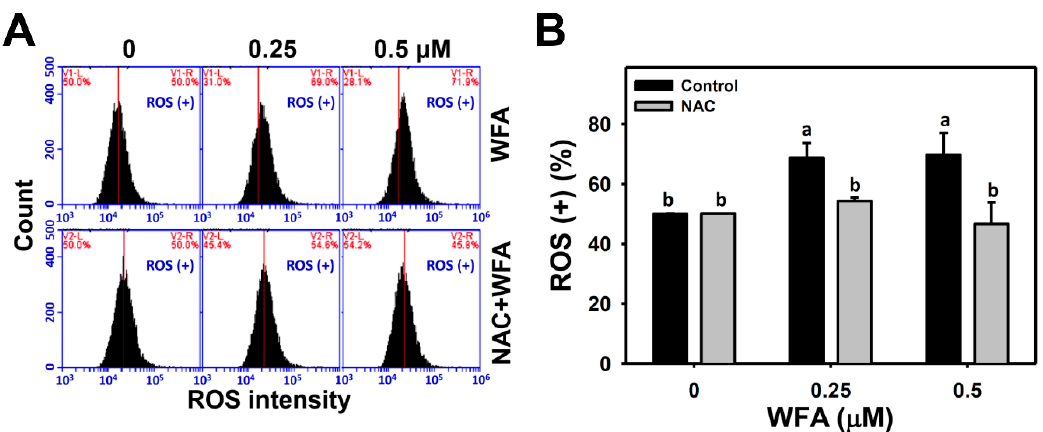
Figure 2. ROS generation effects of low concentrations of WFA in oral cancer cells. ( A ) ROS patterns of Ca9-22 cells after NAC and/or WFA treatments. Cells were pretreated with or without NAC (2 mM, 1 h) and post-treated with different concentrations of WFA for 24 h, i.e., NAC + WFA vs. WFA. ROS-positive population is marked as ROS (+). ( B ) Statistics of ROS change in Figure 2A. For multiple comparison, treatments without the same labels (a,b) indicate the significant difference. p < 0.05~0.001. Data, mean ± SD ( n = 3).